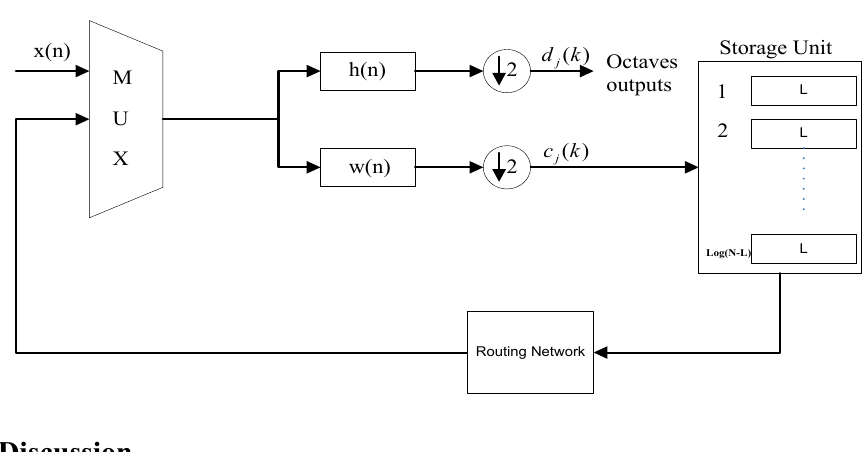
Figure 8. RPA implementation architecture.